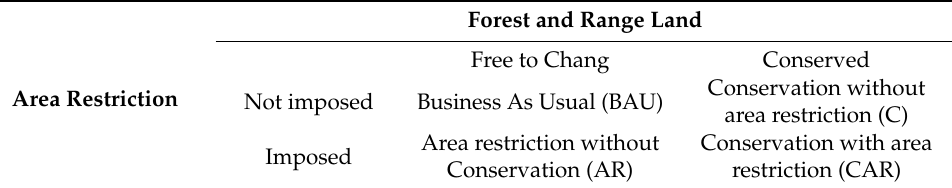
Table 2. Policy scenarios